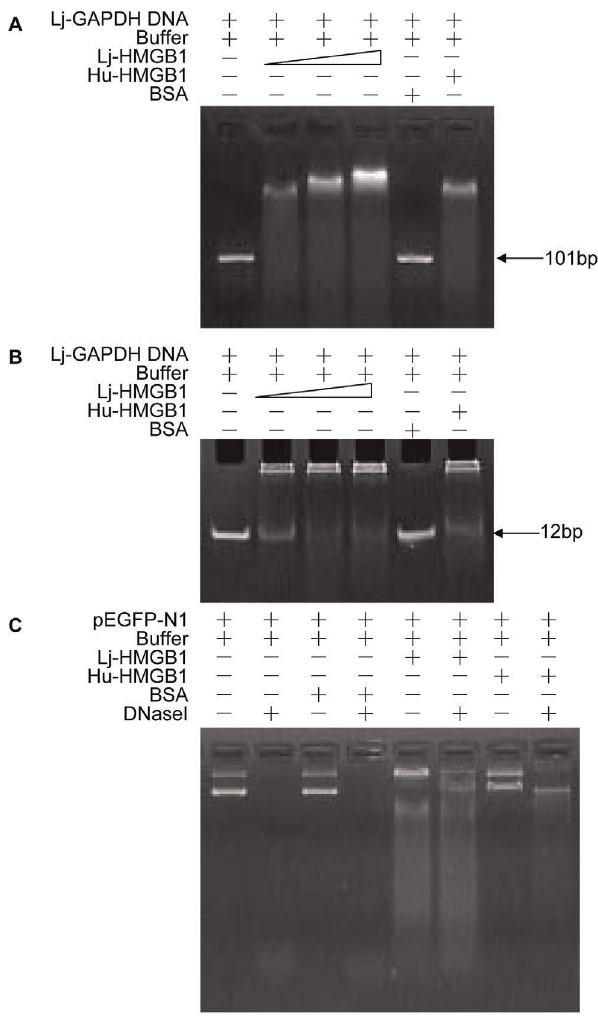
Figure 6. EMSA of lamprey HMGB1 binding to double-stranded polynucleotides. Double-stranded lamprey GAPDH DNA (100 ng, 101 bp and 12 bp in length) was incubated with purified Lj-HMGB1 protein at various concentrations, and aliquots were taken for electrophoresis on a 2% agarose gel (A) and a 20% native PAGE gel (B). Lane 1, Tris buffer; Lane 2, 10 ng of Lj-HMGB1; Lane 3, 20 ng of Lj- HMGB1; Lane 4, 30 ng of Lj-HMGB1; Lane 5, 30 ng of BSA; Lane 6, 10 ng of human HMGB1. (C). DNA hydrolysis in the presence of rLj-HMGB1. pEGFP-N1 DNA (4730 bp, 100 ng) was hydrolyzed by DNase I in the presence of rLj-HMGB1. Tris buffer (lane 2), BSA (lane 4), rLj-HMGB1 (lane 6) or human HMGB1 (lane 8) were incubated with pEGFP-N1 DNA at a quantitative ratio of 1:10 in 20 mM Tris-HCl buffer containing 2 mM MgCl 2 (pH 8.0) at room temperature for 10 min. DNase I (0.05 units, TaKaRa) was then added to each sample to hydrolyze pEGFP-N1 DNA at 37 u C for 10 min. Tris buffer (lane 1), BSA (lane 3), rLj-HMGB1 (lane 5) or human HMGB1 (lane 7) incubated with pEGFP-N1 DNA without DNase I served as the controls. The aliquots were analyzed on 1% agarose gels.